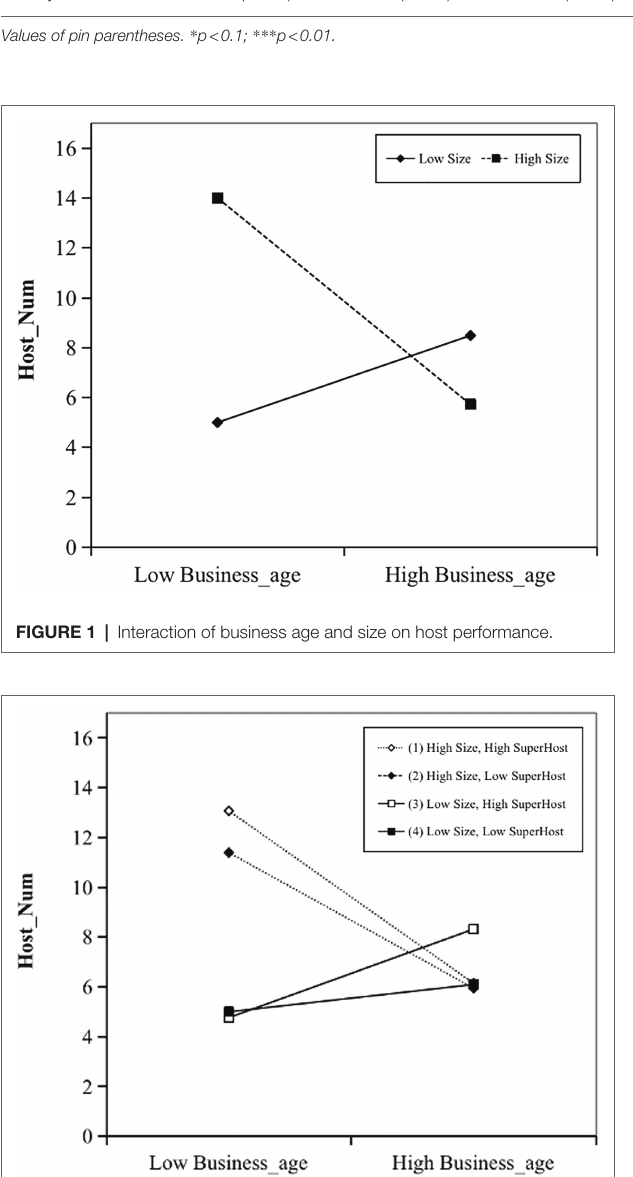
1, Business_age and control variables were introduced. The results suggest that Business_age has a significantly positive effect on Host_Num ( β = 0.147, p < 0.01). Hypothesis 1 was